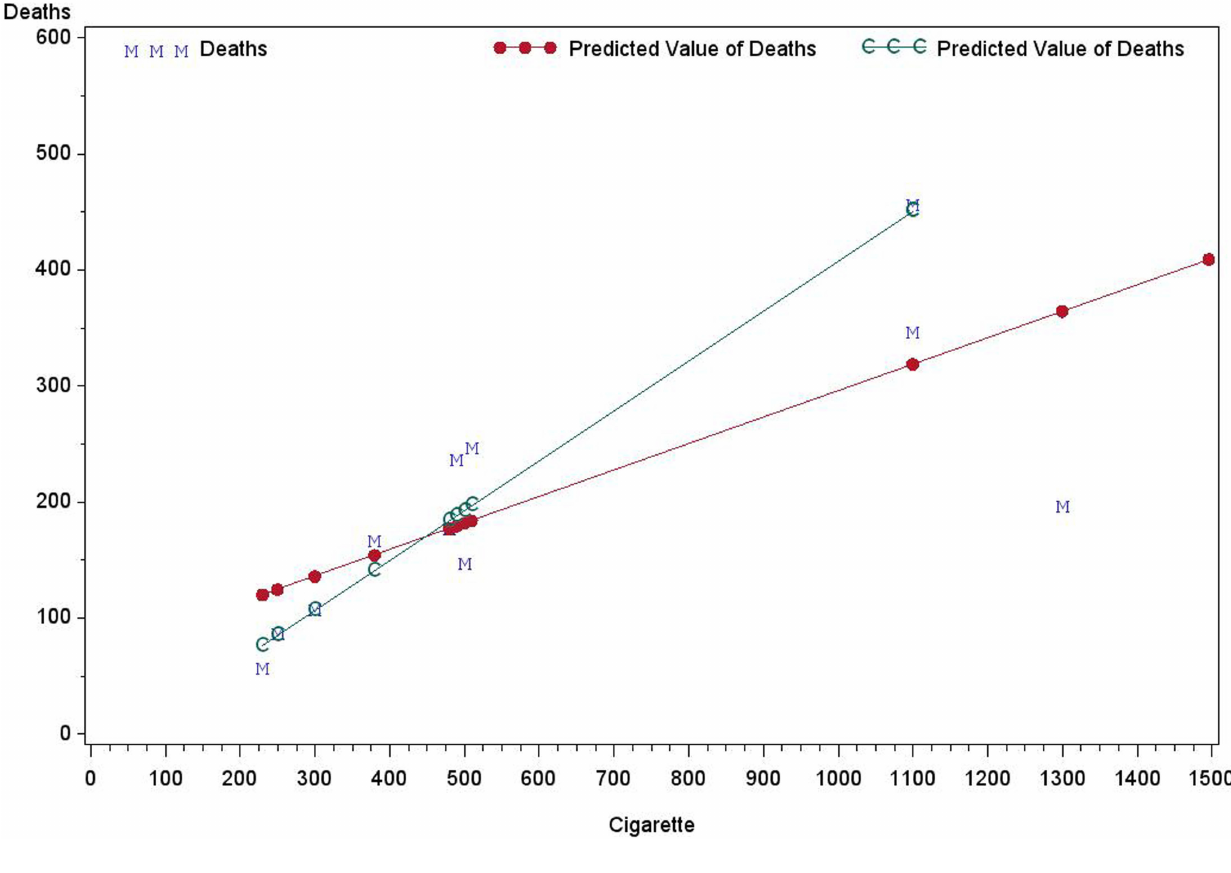
FiGURe 1 | The deaths by cigarette using: regression with USA and without USA .